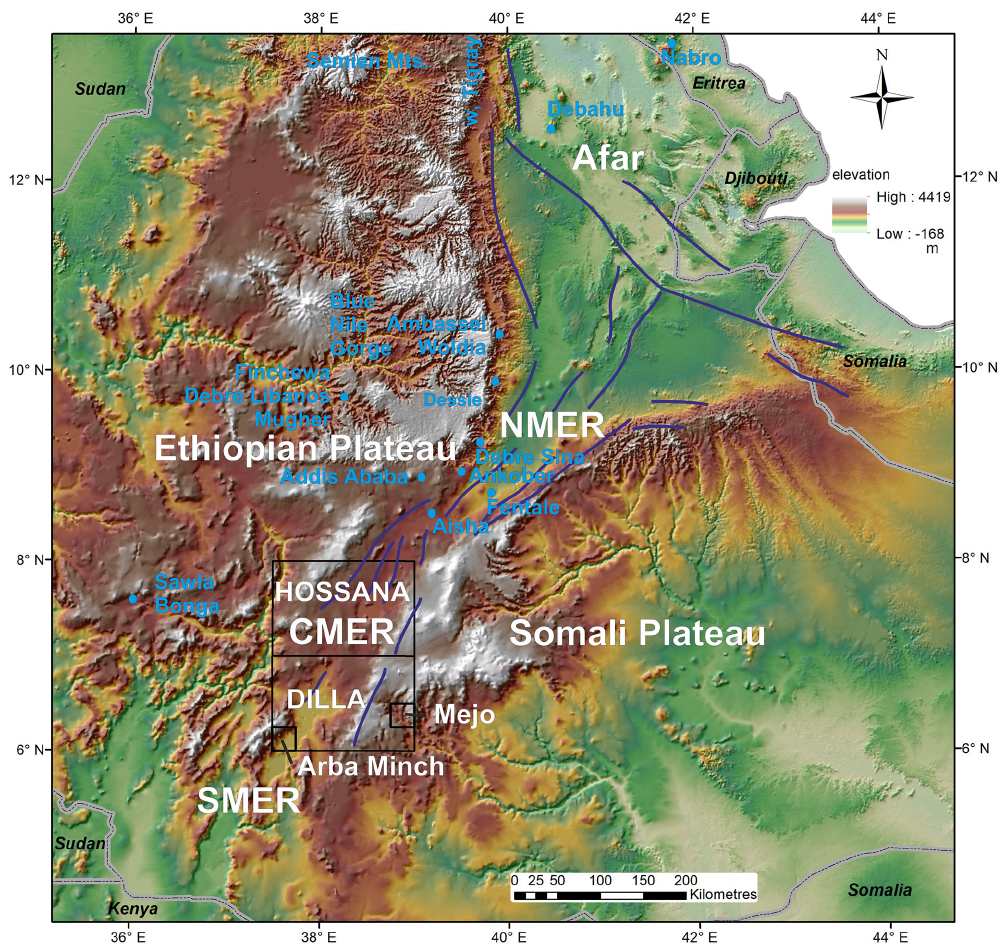
Figure 1. The Hossana and Dilla areas in the central and southern part of the Main Ethiopian Rift (MER). The location of the NMER (northern MER), CMER (central MER), SMER (southern MER), Mejo, and Arba Minch case study areas are also indicated. The blue lines represent major fault zones. Digital elevation models ASTER DEM and SRTM3, with a resolution of 30m, were used (USGS EROS Archive; NASA LP